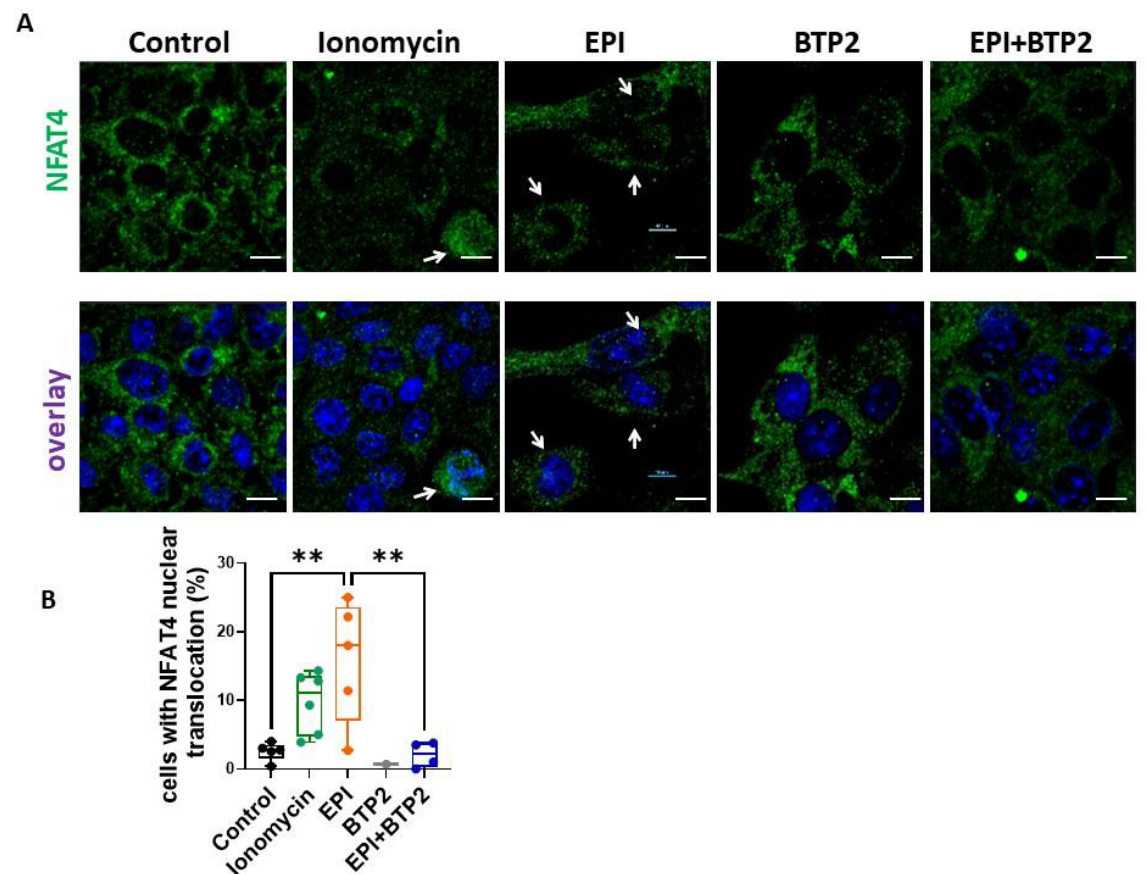
Figure 6. BTP2 inhibited the EPI-induced nuclear translocation of NFAT4 in HL-1 cardiomyocytes. HL-1 cells were treated with vehicle, 1 µM EPI, 20 µM BTP2, or 1µM EPI combined with 20 µM BTP2 for 5 h, followed by drug withdrawal and culture for 24 h and stained for NFAT4. Cells treated with 10 µM ionomycin for 15 min were used as positive control. ( A ) Representative confocal images of NFAT. Scale bar, 10 µm. white arrows indicate the co-localization of NFAT4 and Nuclei ( B ) Statistical analysis of the percentage of cells with NFAT nuclear translocation. Each dot is an averaged datapoint from a single confocal image. Each image represents one biological replicate. Mean ± SD. **: p < 0.01 (based on one-way ANOVA and Bonferroni post hoc